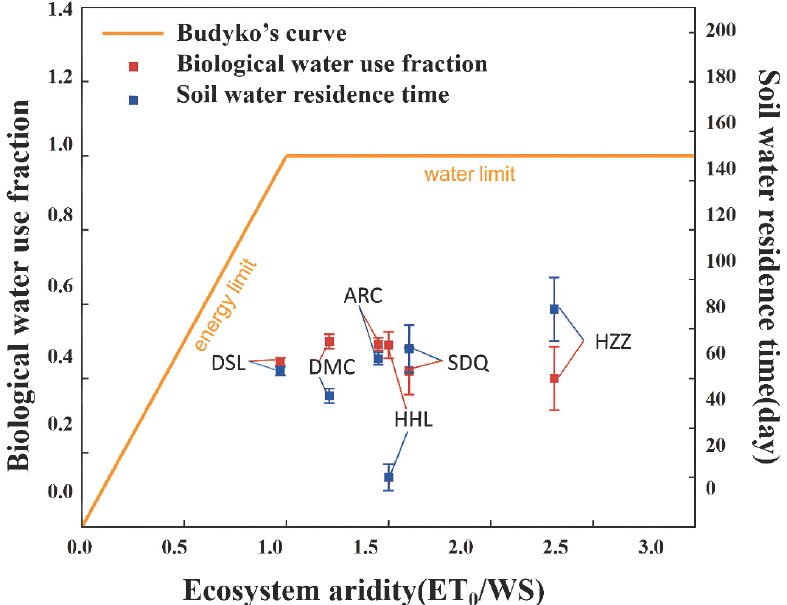
Figure 5. The biological water use fraction and soil water residence time (for 40 cm depth) plotted with respect aridity in growing season for alpine meadow (ARC), alpines swamp meadow (DSL), cropland (DM), Kalidium foliatum (HZZ), P. euphratica (HHL), T. ramosissima (SDQ). T means transpiration, WS means total water supply in ecosystems, ET 0 calculated with FAO Penman Monteith equation.